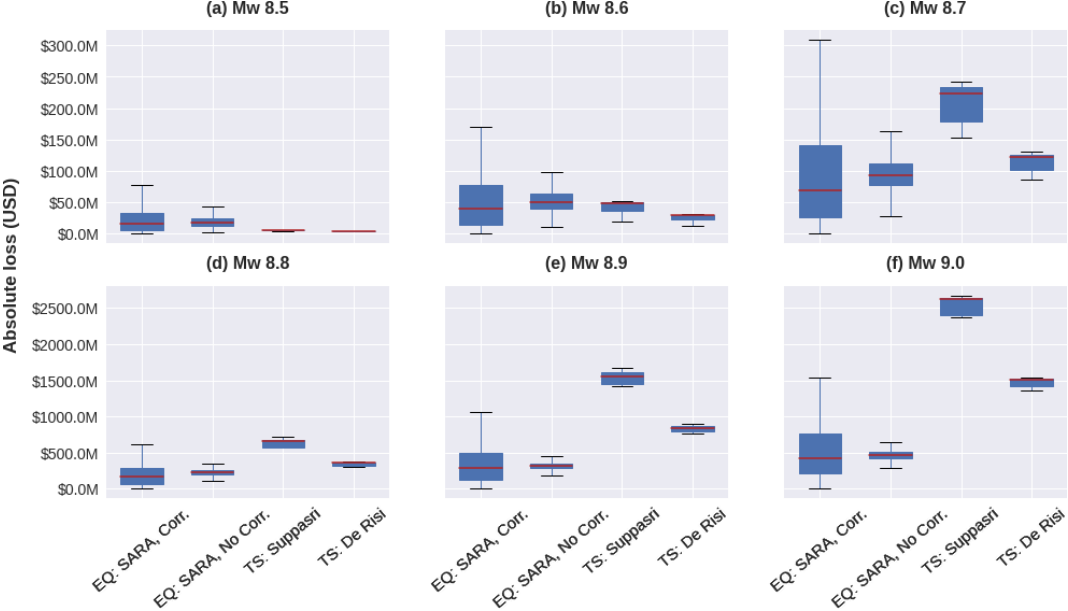
Figure 19. Comparison of the independent earthquake-induced losses (EQ) for two ground motion field conditions (using the 1000 GMF for each case: with a spatial cross-correlation model (Corr.) and spatially uncorrelated model (No Corr.) and the tsunami-induced losses (TS) under two tsunami reference schemes for six magnitude scenarios over every common area exposed to both